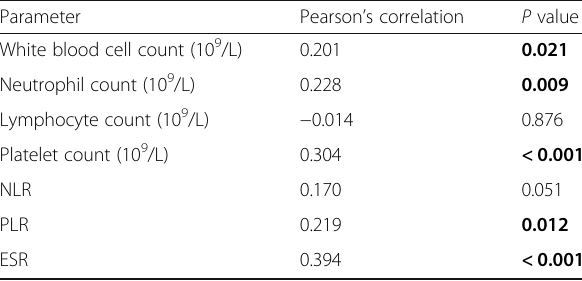
ESR, erythrocyte sedimentation rate; n, number; NLR, neutrophil/lymphocyte ratio; PLR, platelet/lymphocyte ratio; P value, probability value